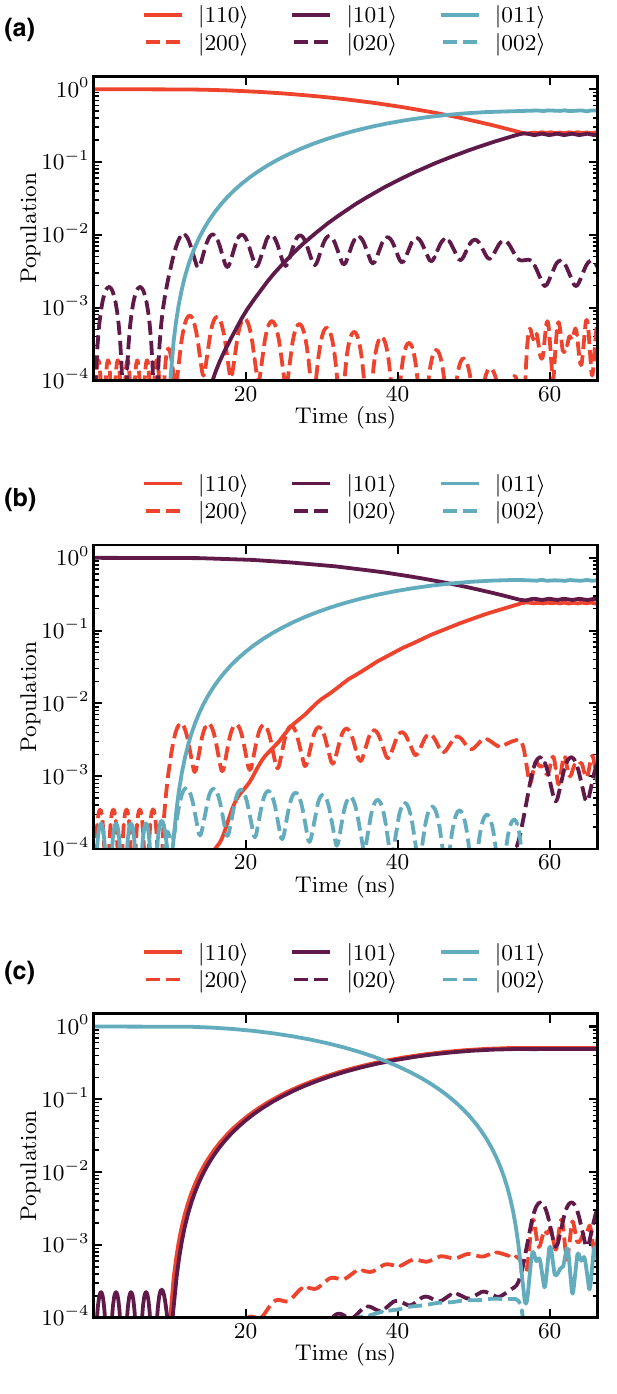
FIG. 16. Population transfers for different initial states [(a) | 110 (cid:2) , (b) | 101 (cid:2) , (c) | 011 (cid:2) ] in the two-excitation subspace in the implementation of the DIV gate with tunable qubits. All simu- lation parameters and notation conventions are the same as for Fig. 14 in the main